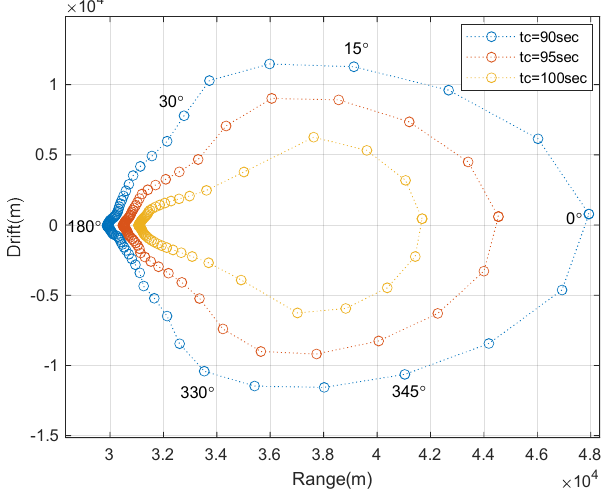
Figure 11. Foot Print Area.